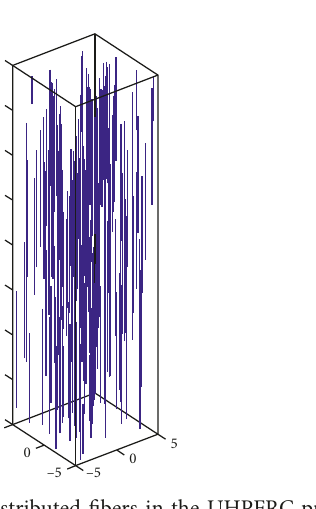
Figure 10: Aligned distributed fibers in the UHPFRC